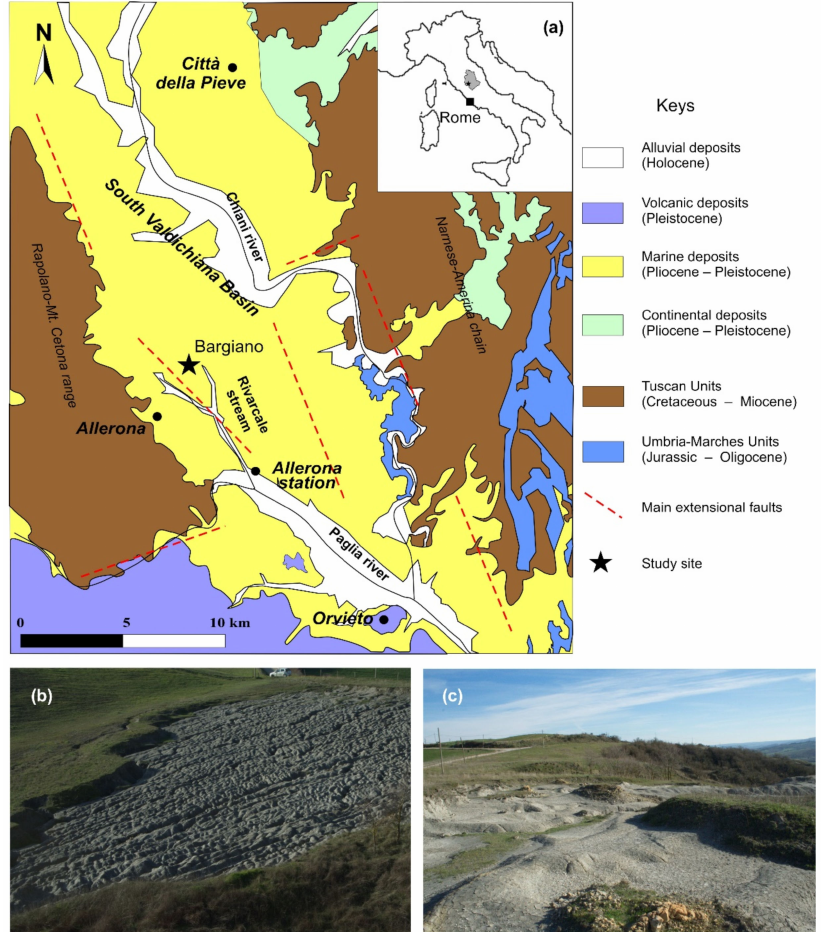
Figure 1. Geographic localization of the study area (Umbria region, Italy) and main features of the study site; ( a ) simplified geological map of the study site: Information on outcropping formations and faults are reported in the legend, and the study site highlighted by the black star (redrawn after [29,30]); ( b ) clayey/silty clayey deposits at Bargiano, showing diffuse and pervasive gully erosion on steep flanks; ( c ) slightly horizontal uppermost surface, showing large mound-shaped fossil structures of Ambergrisichnus alleronae